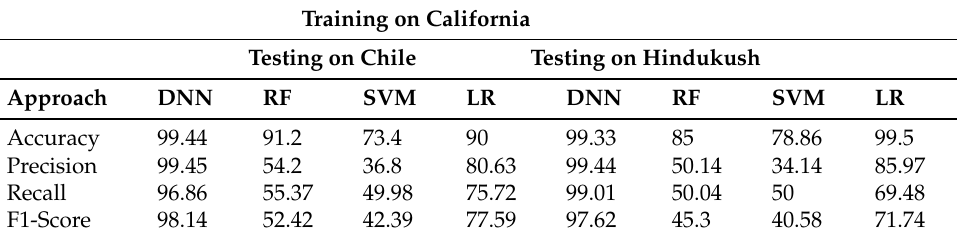
Table 6. Training on California, and testing on Hindukush and